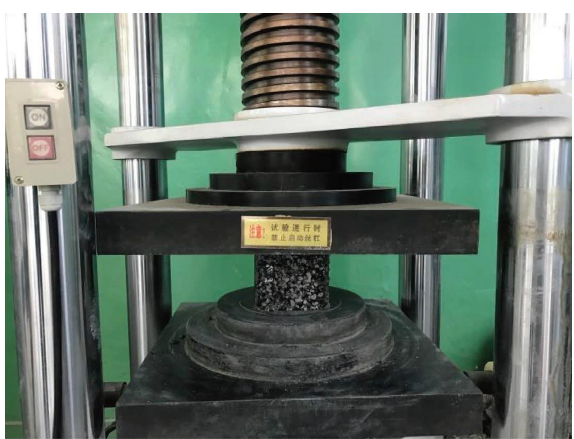
Figure 7: experimental device of compressive strength.